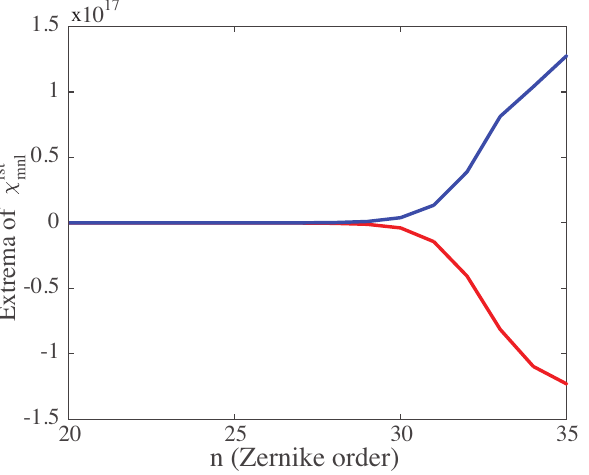
factors . We show the maxima (in blue) and minima (in red) nlm